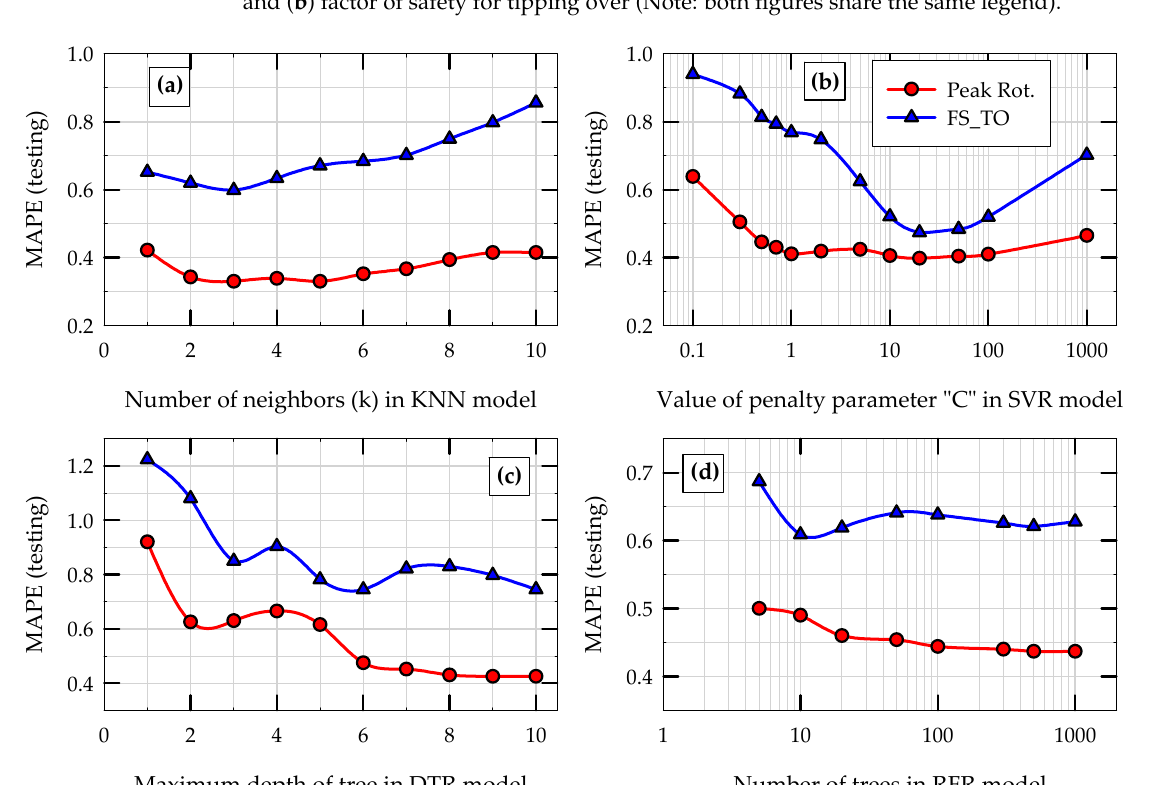
Figure 9. Comparison of model performances in terms of mean absolute percentage error (MAPE) in predictions during initial training and testing phases of machine learning models: ( a ) peak rotation and ( b ) factor of safety for tipping over (Note: both figures share the same legend).